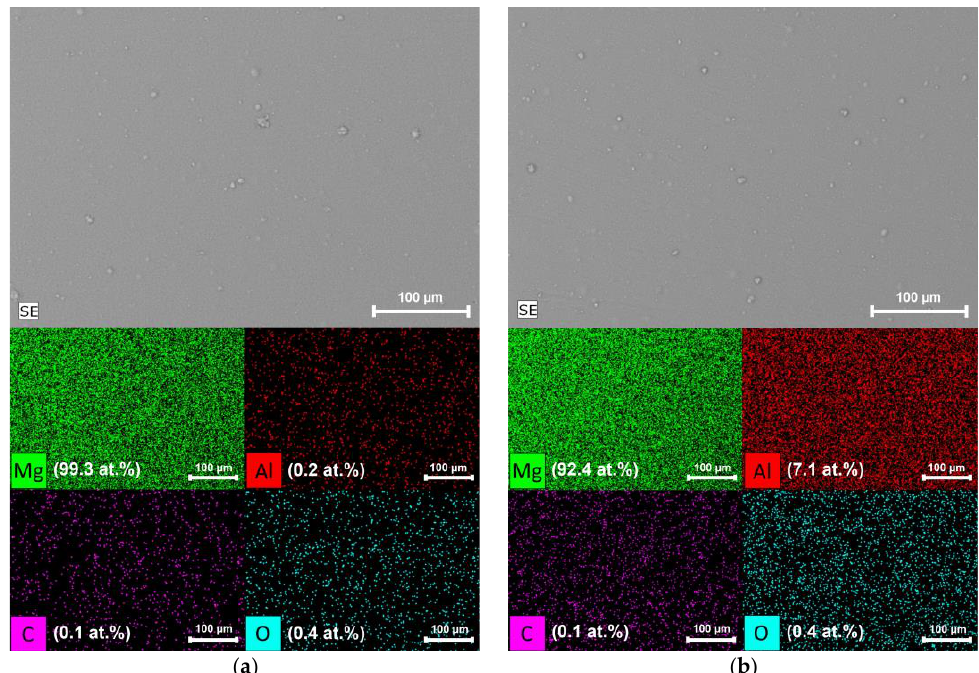
Figure 5. SEM images and elemental mapping from the surface of ( a ) Mg coating; ( b ) Mg-10%Al coating.